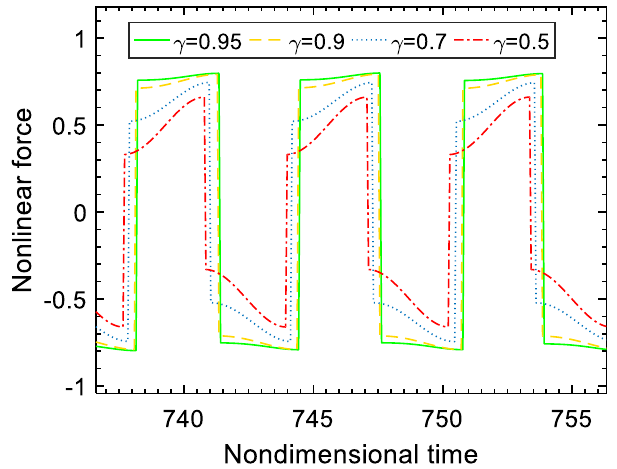
Figure 5. Nonlinear force of dual-connected SSDI in different voltage inversion factor ( γ ).